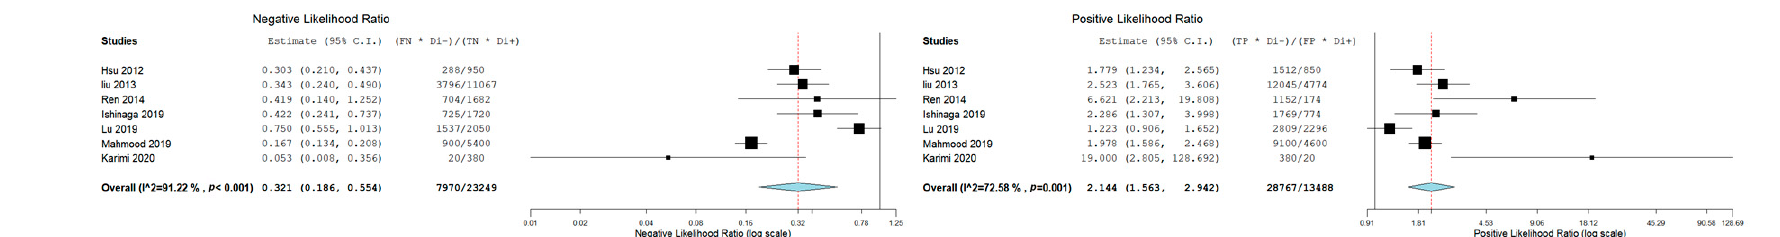
Figure 4. Forest plot of the positive likelihood ratio and negative likelihood